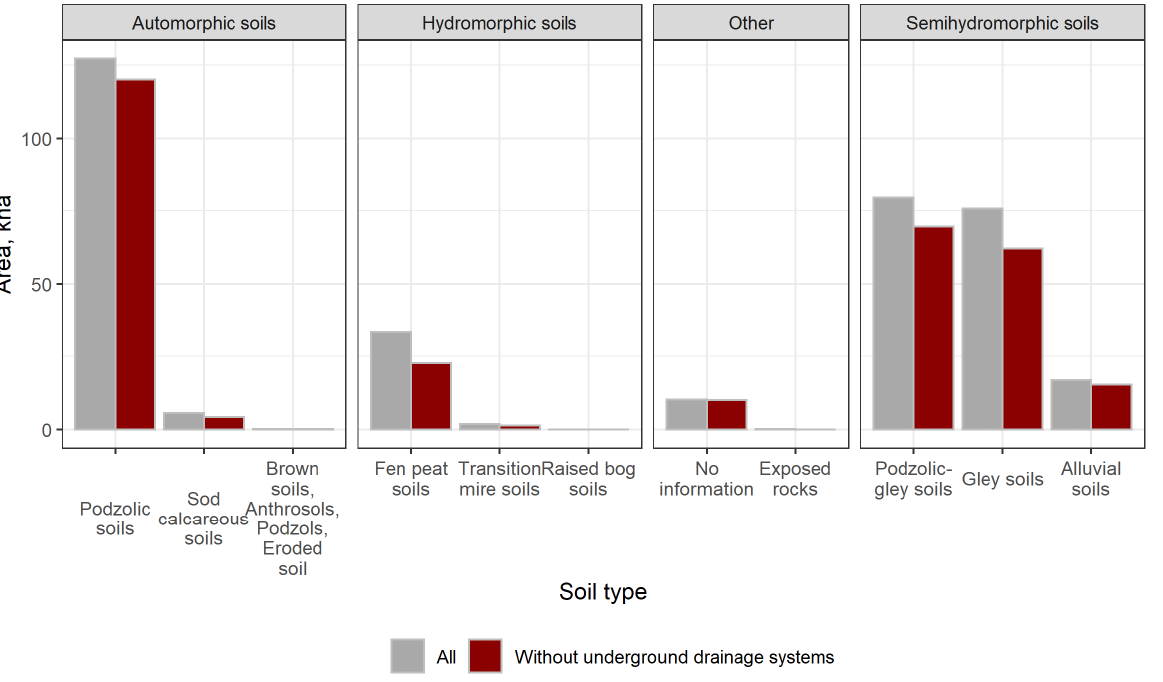
Figure 5. Area of low-value agricultural land parcels suitable for agroforestry by soil type.